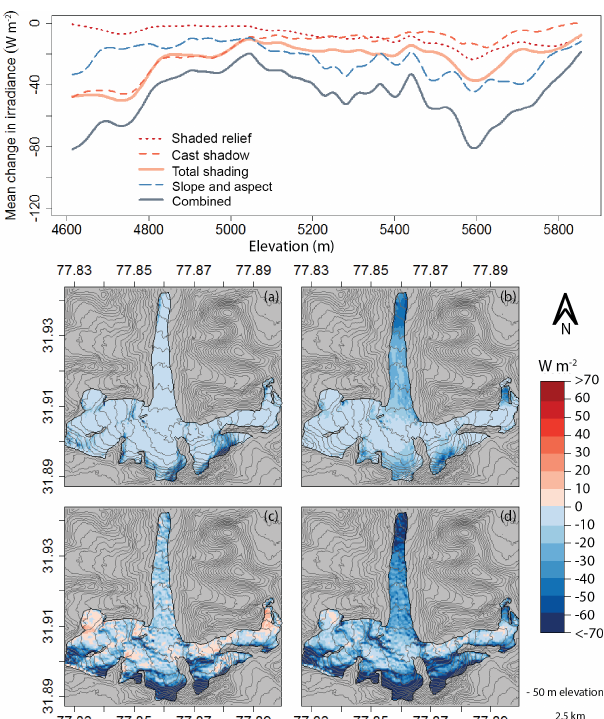
Figure 5. Nianchu Glacier. Mean change in irradiance throughout the summer melt season due to shaded relief (a) , cast shadowing (b) , slope and aspect (c) , and combined topographic components (d)